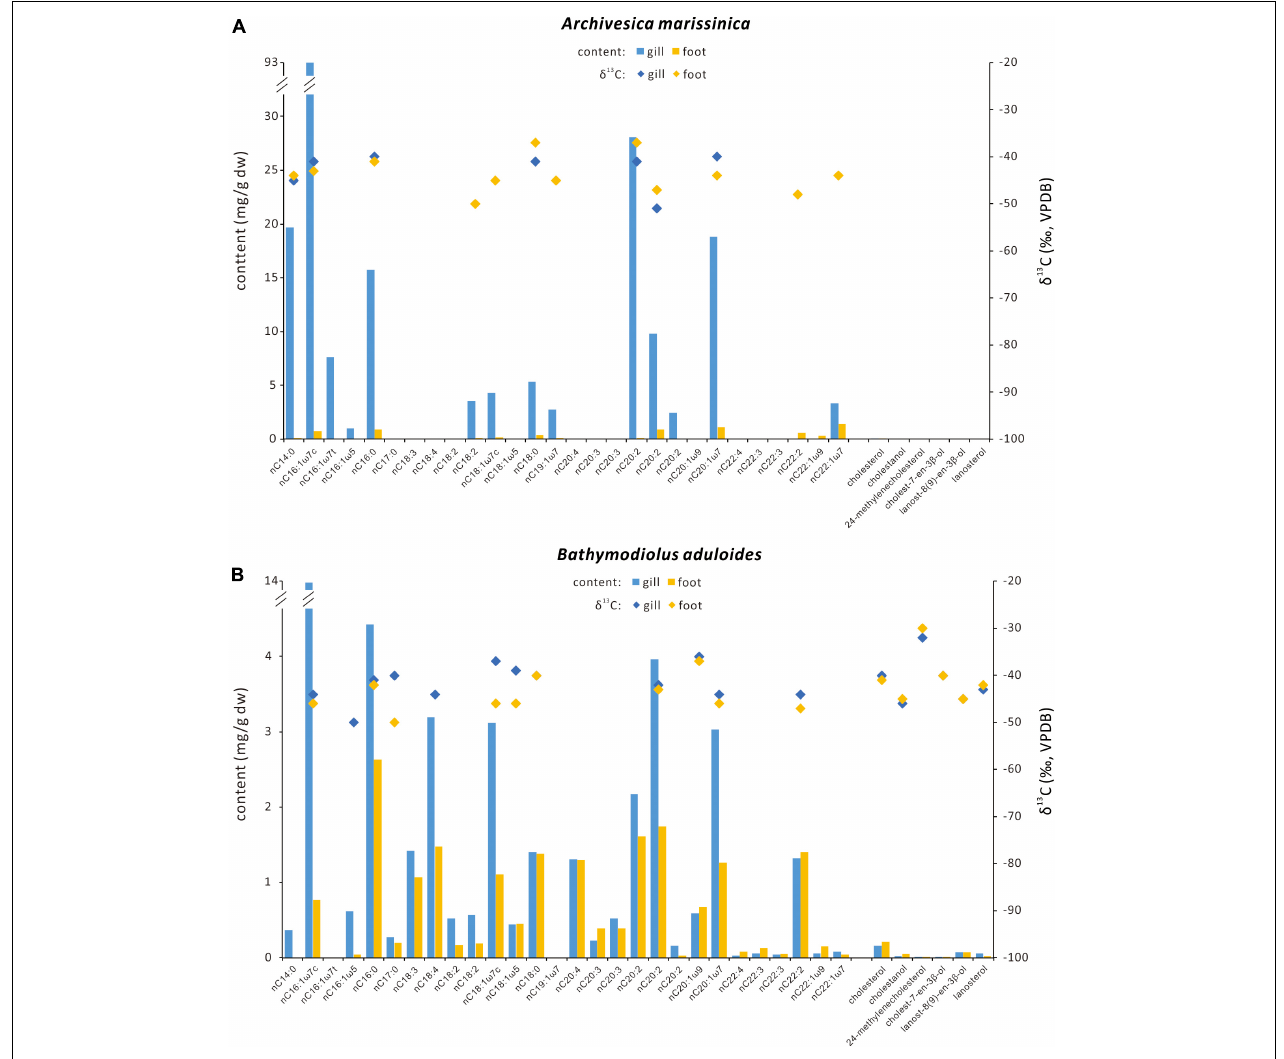
FIGURE 7 | Contents and carbon isotopic compositions of selected fatty acids and sterols for (A) Archivesica marissinica and (B) Bathymodiolus aduloides . Blue bars = contents of gill tissues; orange bars = contents of foot tissues; blue diamonds = δ 13 C values of biomarkers from gill tissues; orange diamonds = δ 13 C values of biomarkers from foot